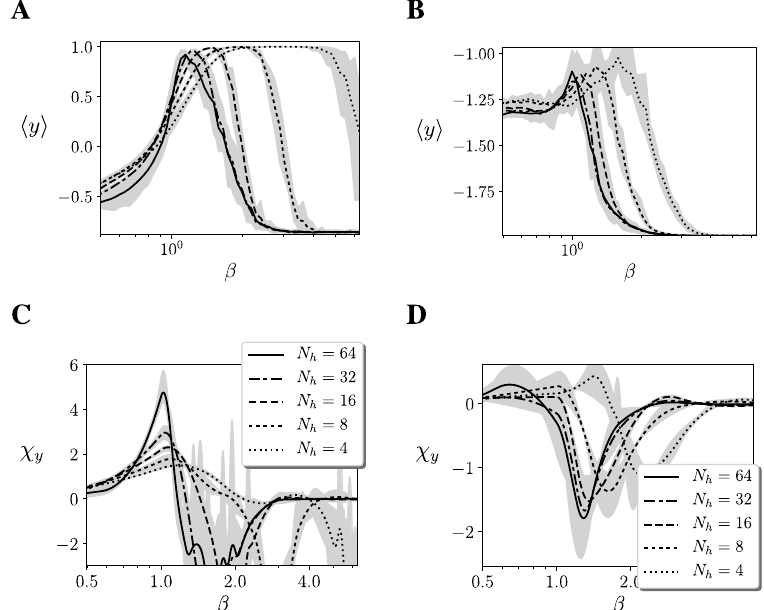
Figure 8. (A,B) Mean height 〈 y 〉 of the agents for different sizes up to N = 70 ( N h = 64), for 10 different agents and 101 values of β . (C,D) Susceptibility of the agent’s behaviour, computed as χ β β = estimated using B-splines. Maximum and minimum values are shown by the grey area. The figures suggest that in both the Mountain Car (left) and Acrobot (right) embodiments the behaviour of the agent presents a sharp transition around β =